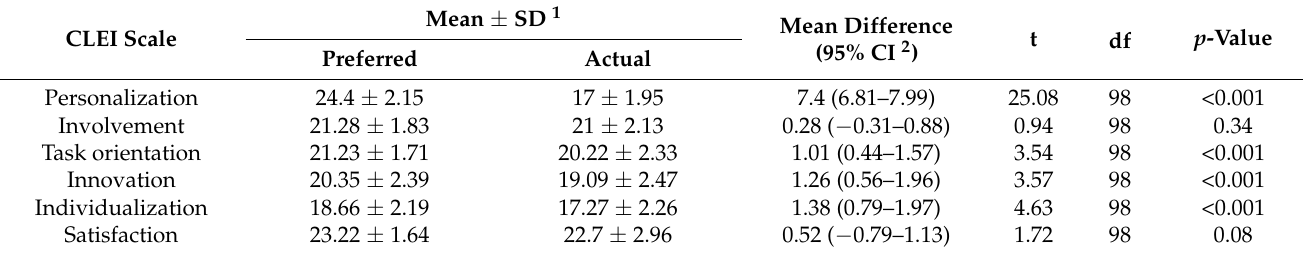
Table 3. Differences between the mean scores of the CLEI-Preferred scales and CLEI-Actual scales ( n = 99).